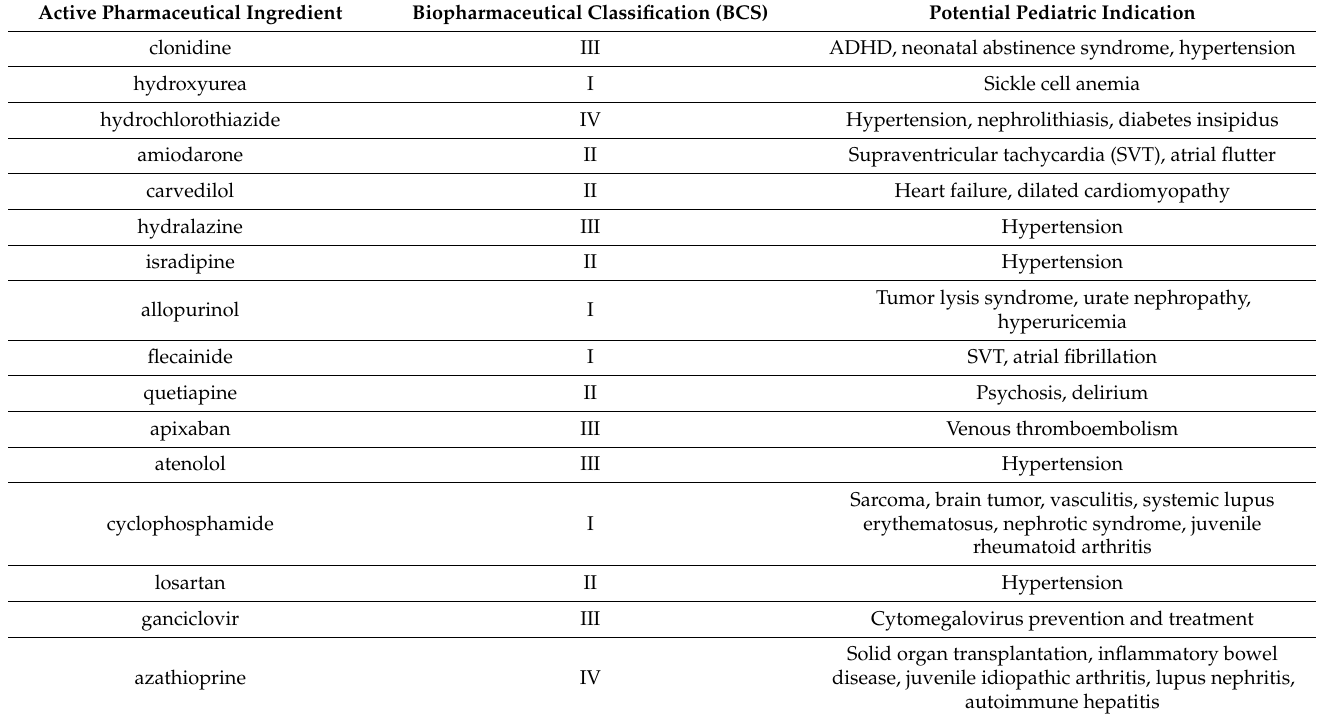
Table 5. APIs with the highest potential for development as commercially available FDA-approved finished liquid dosage forms by BCS